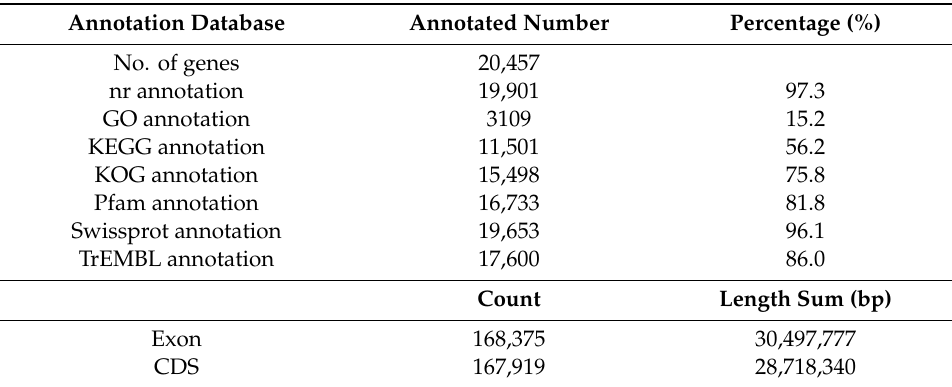
Table 4. Mirounga leonina genome annotation